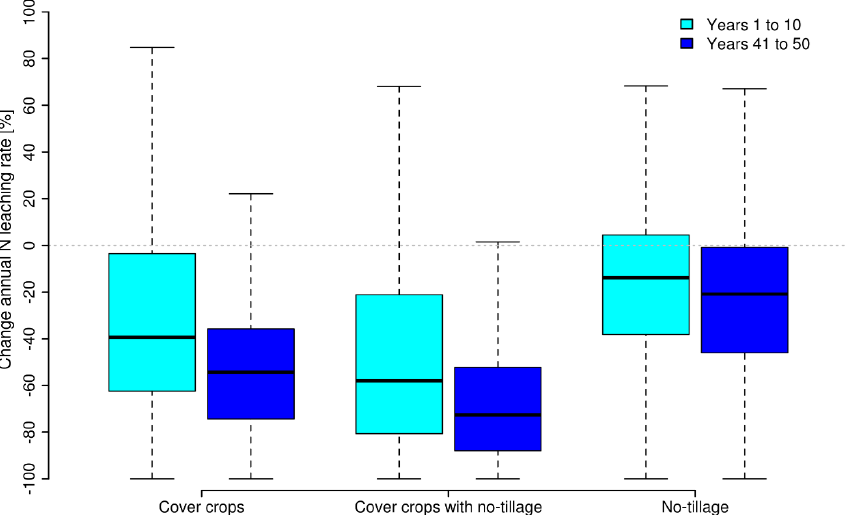
Figure 3. Boxplots of relative differences (%) per hectare cropland ( ∼ 1500 × 10 6 ha) between annual N leaching rates in each of the simulated alternative management scenarios (CC, CCNT, and NT) compared to the baseline (REF) in the first (left bars, cyan) and last decades (right bars, blue) of the 50-year simulation period. The black mid-lines of boxes indicate the median responses per period, hinges of boxes show the first (Q1) and third (Q3) quartiles, and whiskers extend both to the minimum and maximum values within 1.5 times the interquartile range (IQR) of the distribution (outliers, defined as values outside this range are not shown here).